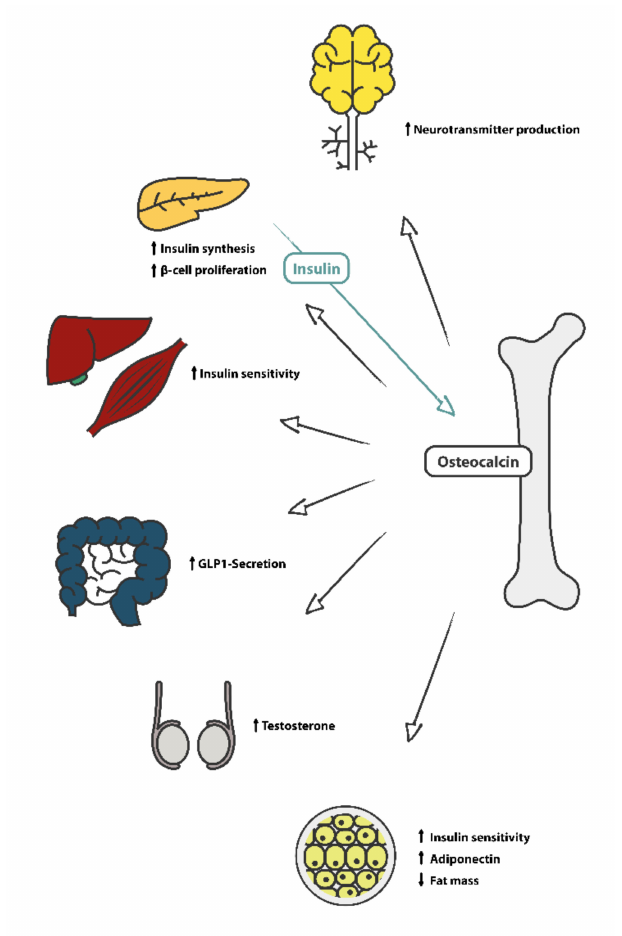
Figure 1. Overview of the different known effects of serum